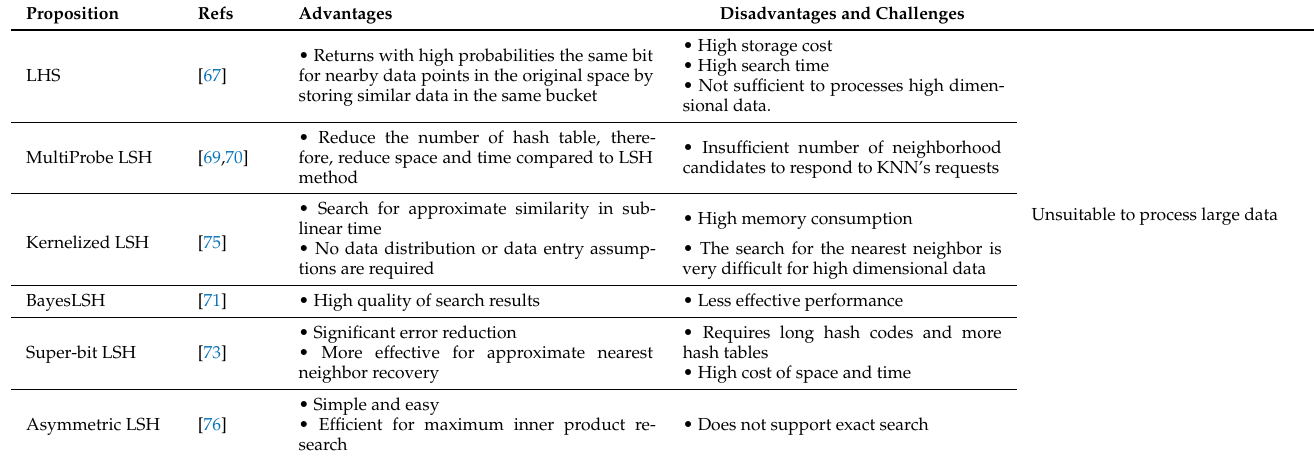
Table 2. Summary of advantage and disadvantage of data independent hashing